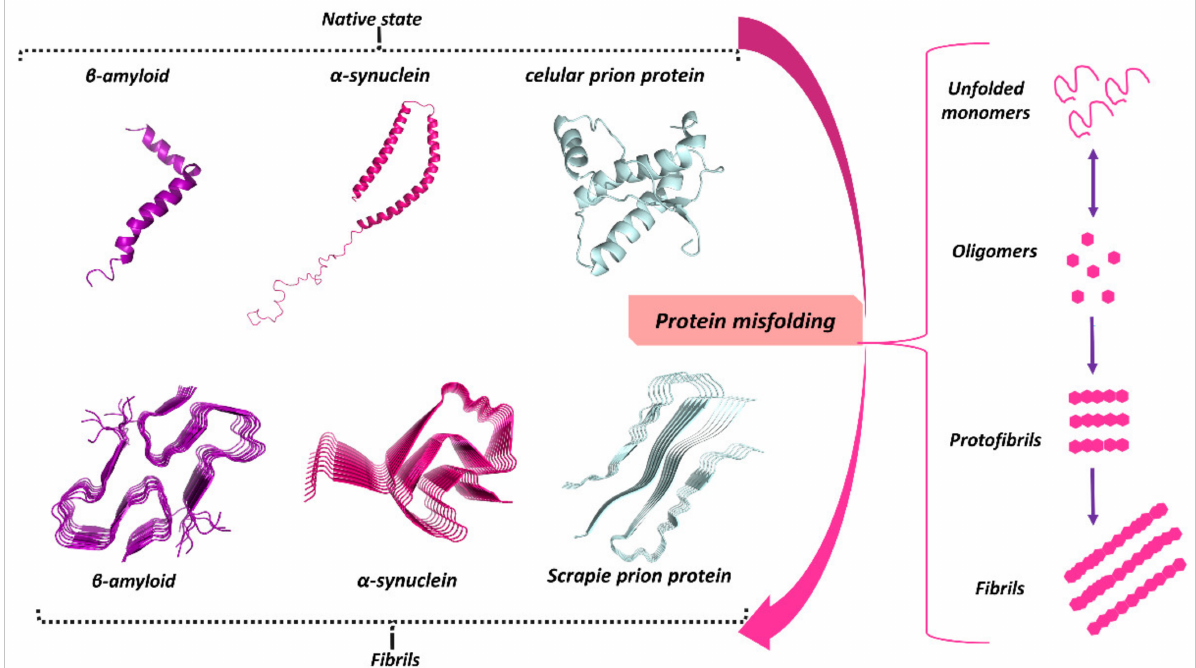
Figure 2. Schematic representation showing that neurodegenerative diseases (NDs) share their origin in protein misfolding followed by the formation of β -sheet-enriched structures. These protein misfolding events are the molecular alterations that trigger several NDs. 3D structures of monomers and fibrils retrieved in the protein data bank (PDB). A β monomer (PDB code: 1IYT); α -syn monomer (PDB code: 1XQ8); murine cellular prion protein (PDB code: 1AG2); A β fibril (PDB code: 5KK3); α -syn fibril (PDB code: 2N0A); prion protein fibril (PDB code: 6UUR). The protein structures here shown were obtained from recombinantly expressed proteins in vitro, except for A β monomer, a chemically synthesized